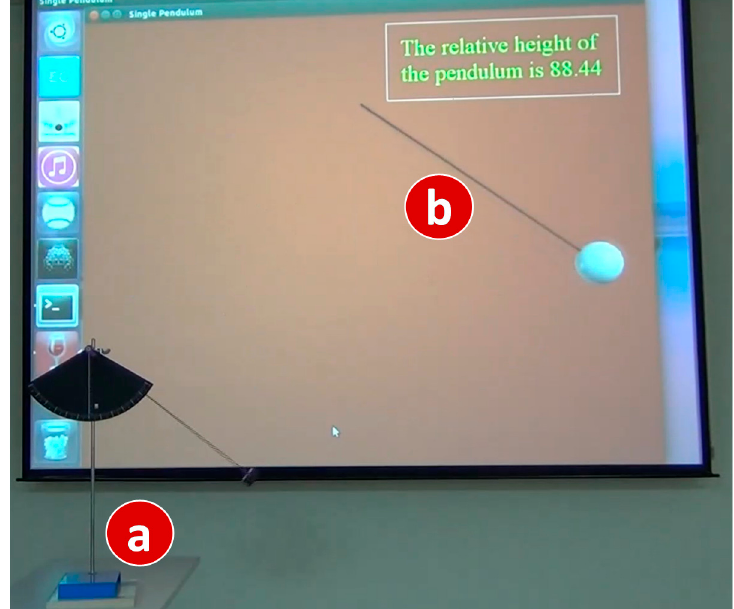
Figure 12. Simulation of pendulum.